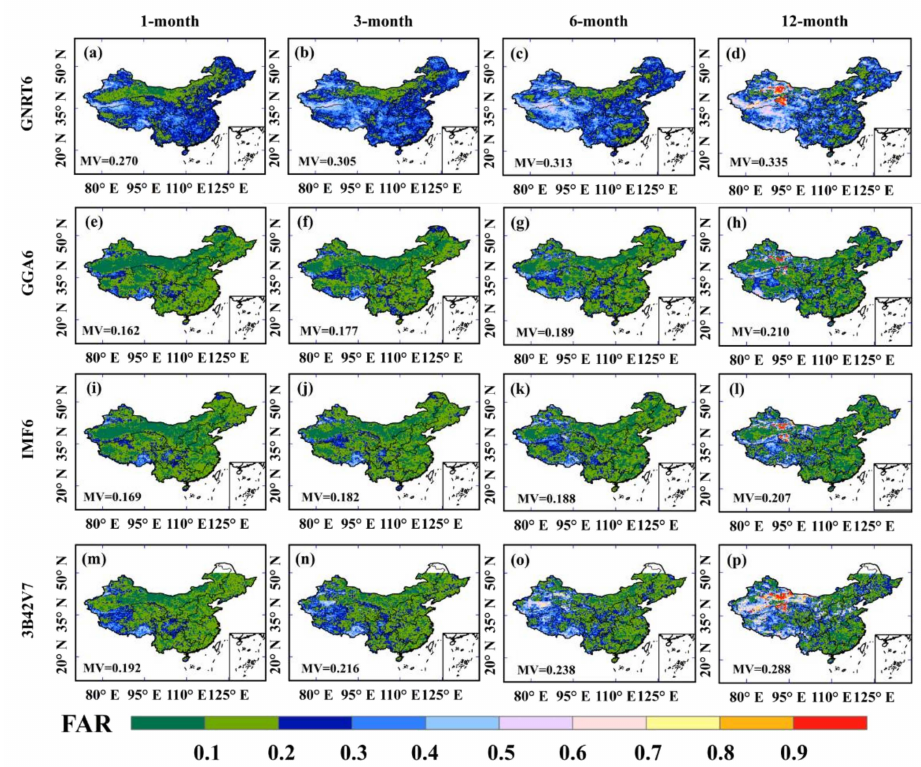
Figure 7. FAR of the ( a , e , i , m ) 1-, ( b , f , j , n ) 3-, ( c , g , k , o ) 6- and ( d , h , l , p ) 12-month SPEI based on the four SREs w.r.t in situ observa-tions in June 2000–May 2019. Columns for different time scales, rows for different SREs.